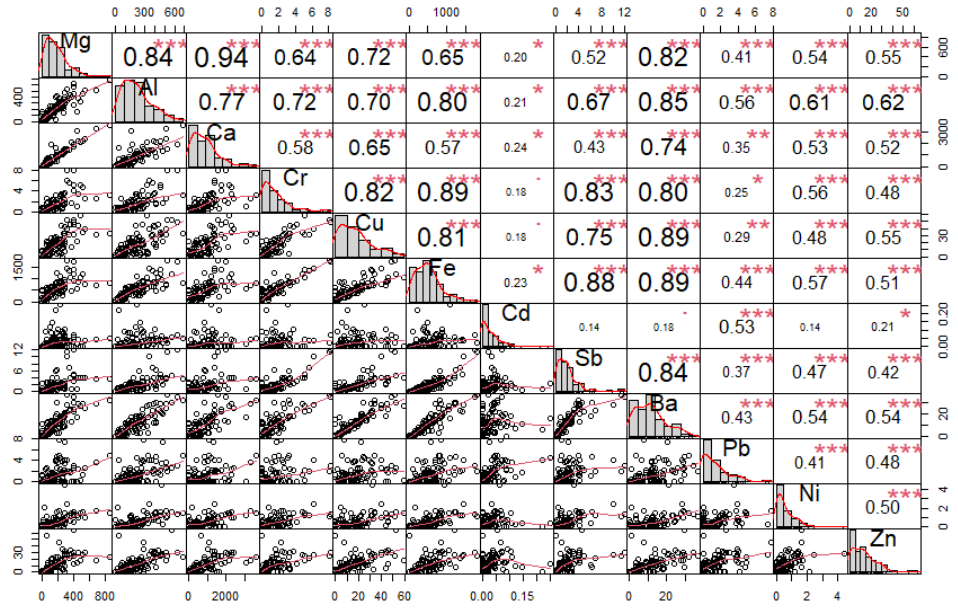
Figure 6. Correlation matrix of elements found in the PM 2.5–10 fraction from measurements taken in the city of Žilina ( p -values (0, 0.001, 0.01, 0.05, 0.1, 1) <=> symbols (“***”, “**”, “*”, “.”, “ “)).